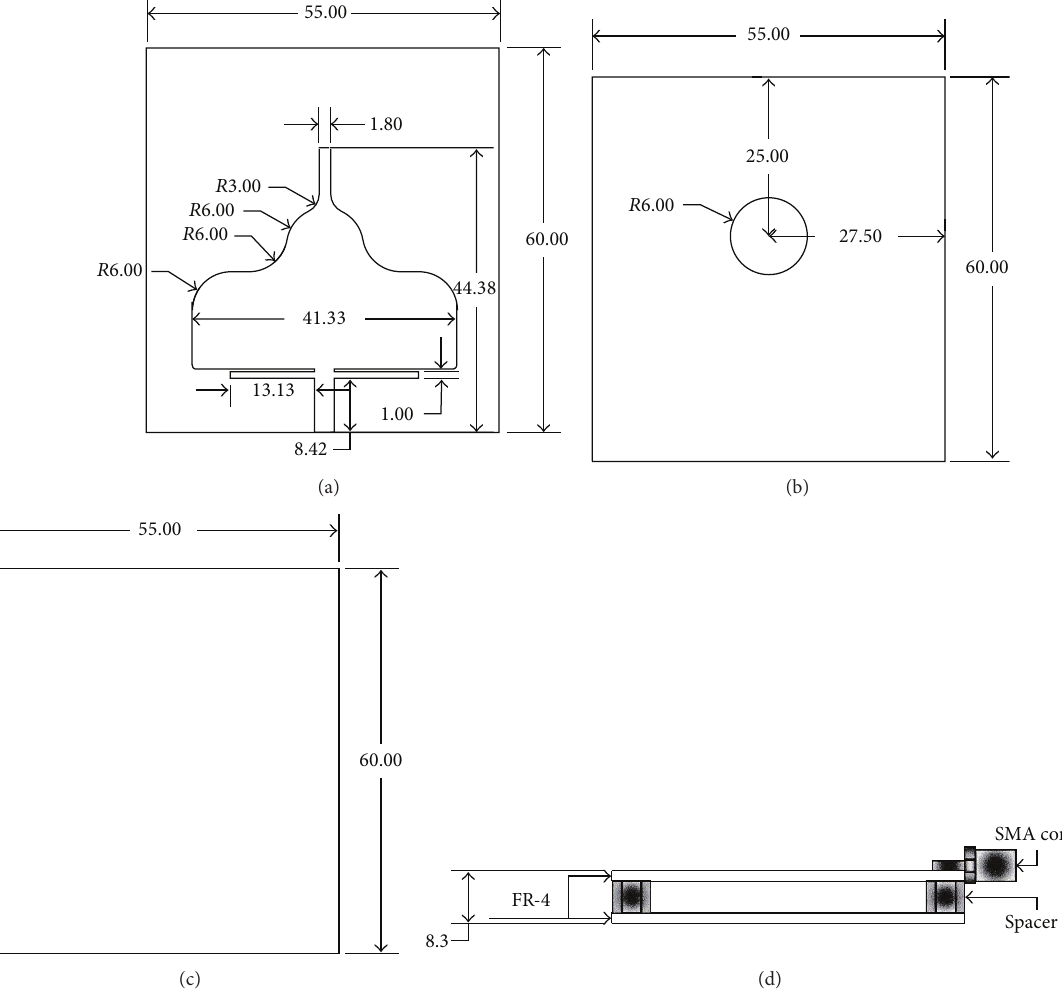
Figure 1: Proposed antenna design. (a) Patch antenna geometry, (b) ground side with circular slot, (c) second FR-4 layer (both sides), and (d) side view of the proposed